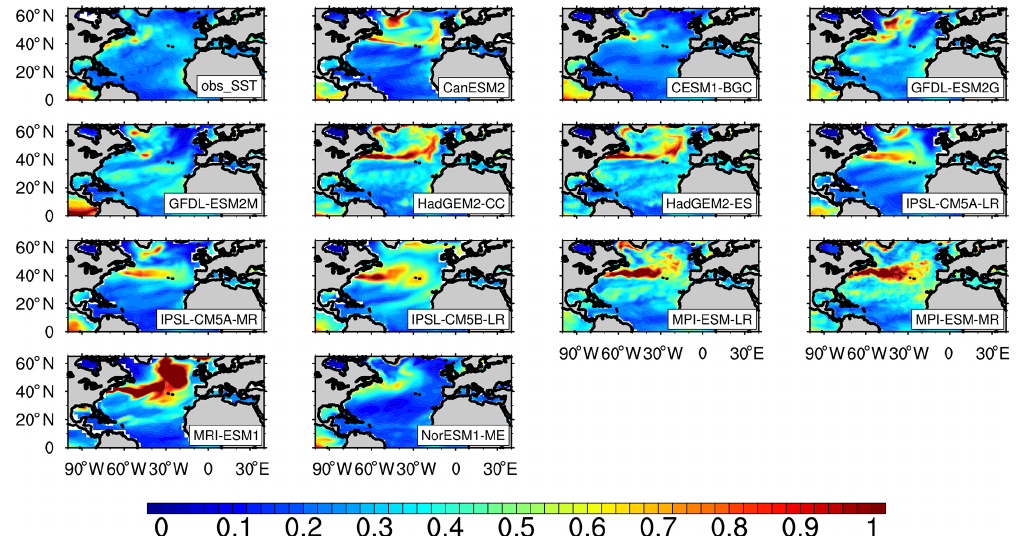
Figure 2. Observed and simulated SST interannual variability ( ◦ , 1SD). The time periods for the observation and models range from 1965 to 2015 and from 1955 to 2005, respectively. The simulated results are based on a historical experiment of CMIP5